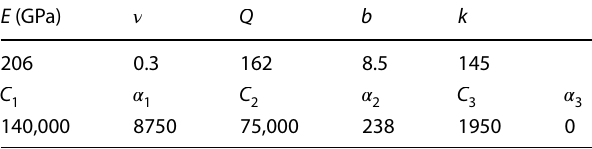
Table 4 Material parameters for the Chacoche combined model